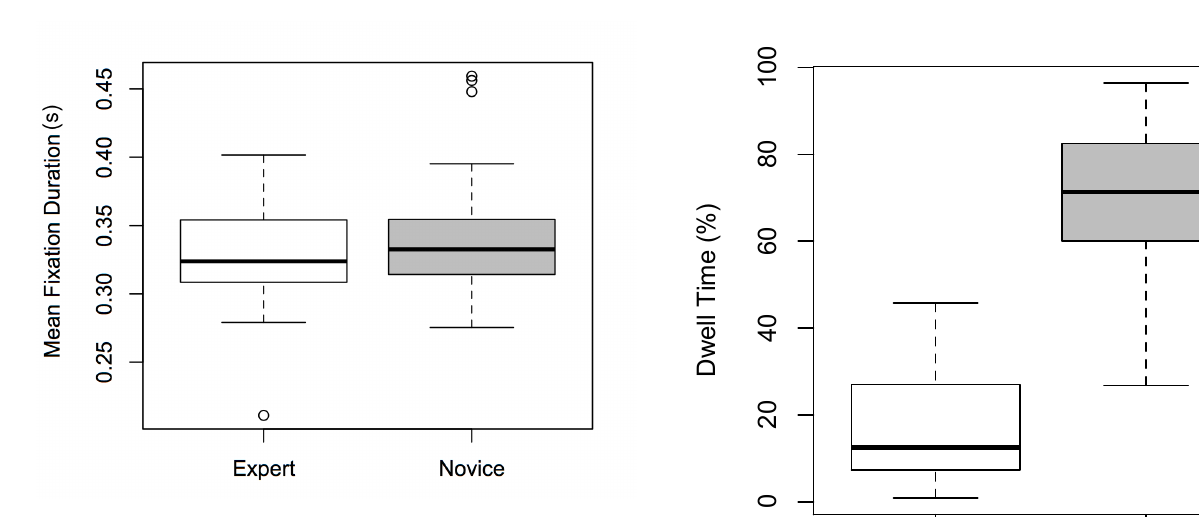
Figure 2. Boxplots of mean fixation durations for Expertise (experts and novices).